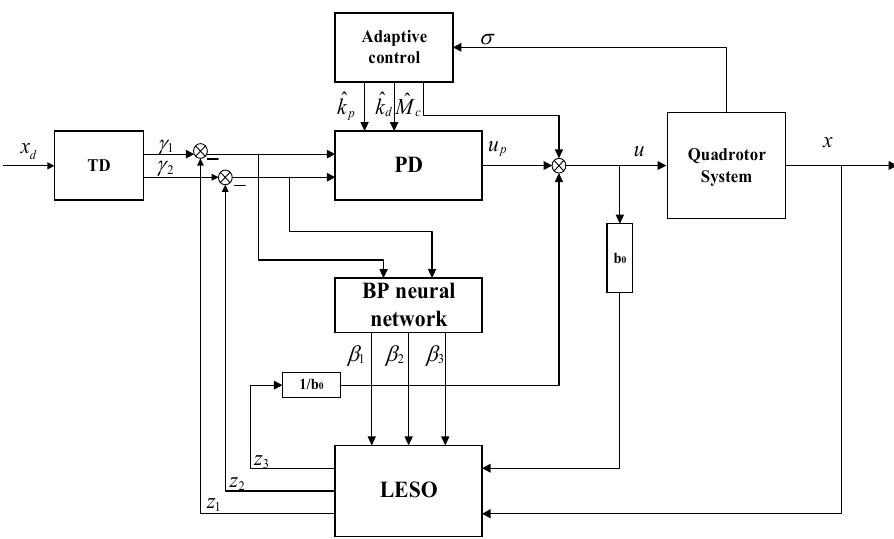
Figure 2. Control scheme structure diagram.